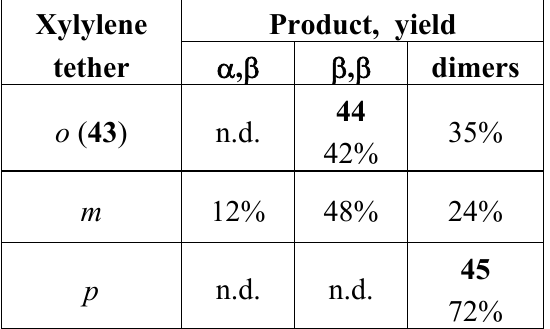
Table 4 . DFA formation from o -, m - and p -xylylene-bridged D -fructopyranose precursors. (n.d., not